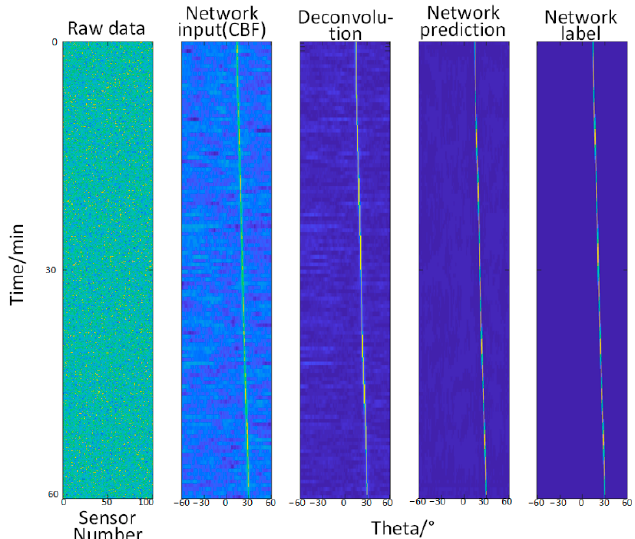
Figure 3. Comparison of angle recognition results between different methods when the signal-to-noise ratio is − 26.78. From left to right: raw data (the abscissa is the sensor number, and the ordinate is the time), the input of the network (the abscissa is the angle, and the ordinate is the time, the same below), deconvolution method, the prediction of the network, and the network label (true trajectory).